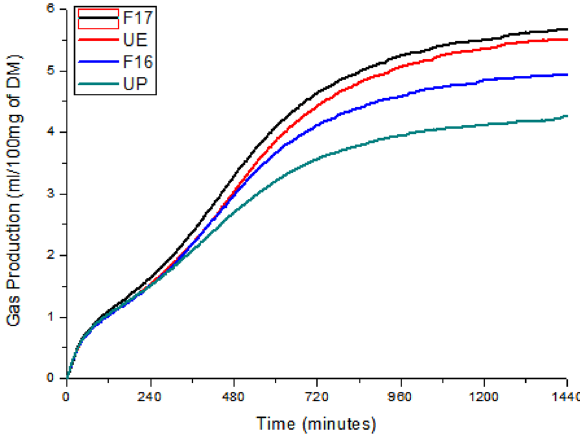
Figure 4. Cumulative gas production of the tested products over 1440 min.